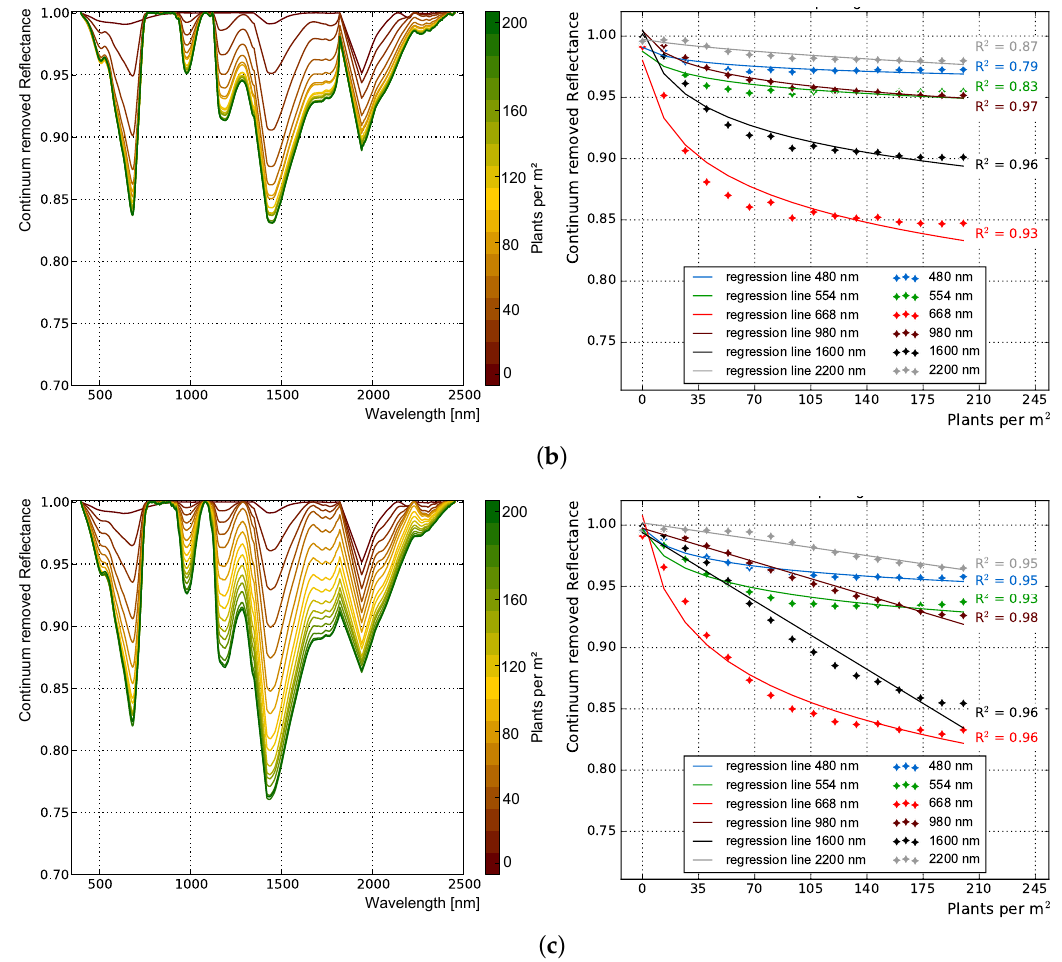
Figure 7. Continuum removed spectra (left) of canopies with varying plant density of ( a ) winter barley; ( b ) winter rye; and ( c ) winter wheat during ripening. Regression analysis (right) between plant density and top-of-canopy reflectance at λ = 480 nm (blue), λ = 554 nm (green), λ = 686 nm (red), and λ = 980 nm (dark red) of ( a ) winter barley; ( b ) winter rye; and ( c ) winter wheat during